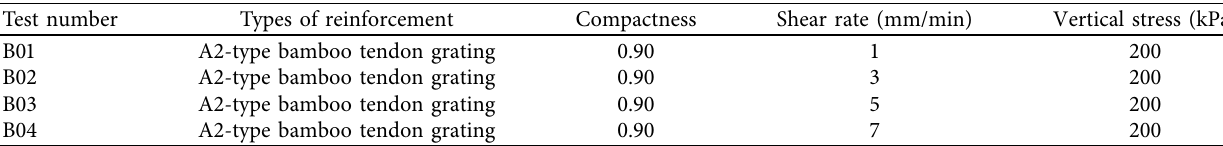
Table 7: Test schemes for different shear